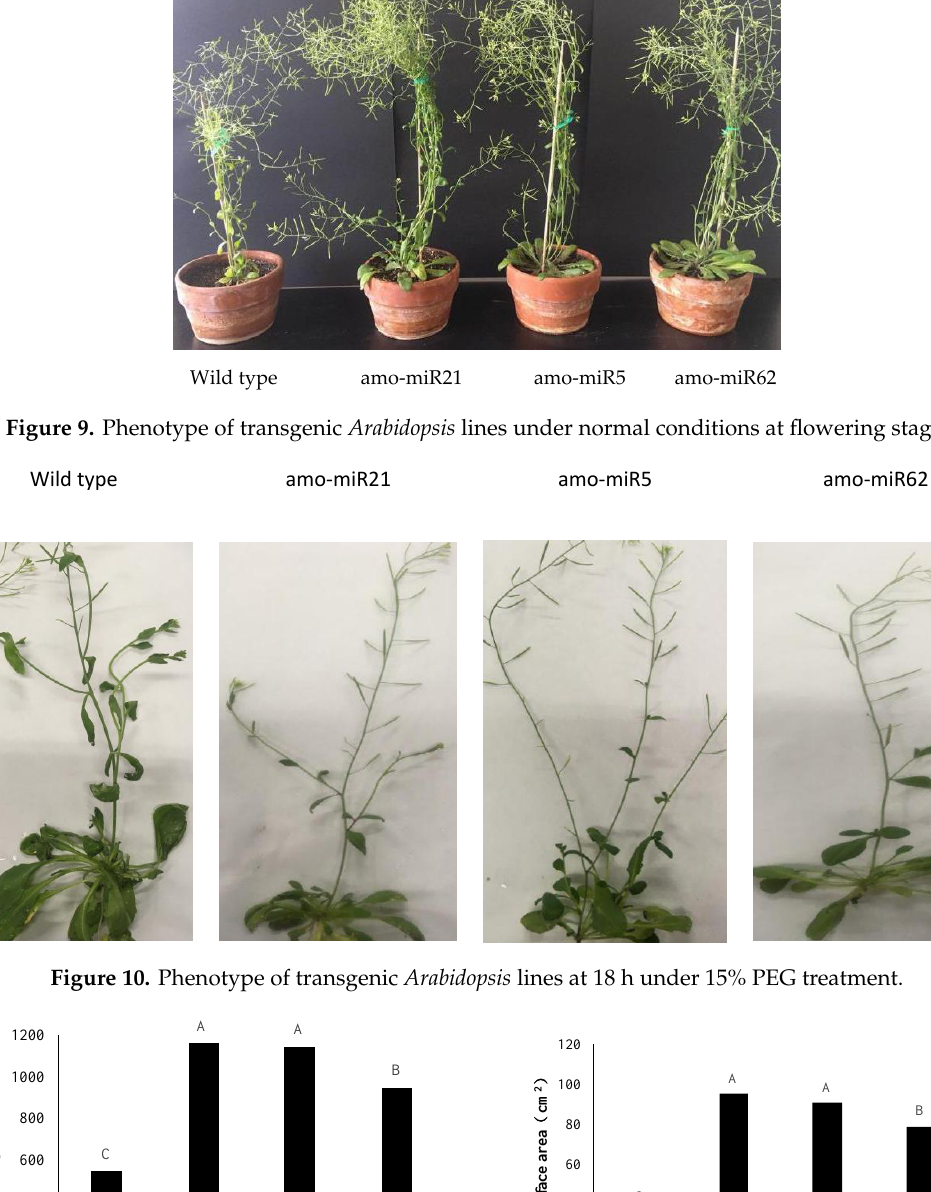
Figure 8. RT-PCR amplification of pre-miRNAs in transgenic plants. Note: M: 100 bp of ladder DL2000 (TIANGEN, Beijing, China).